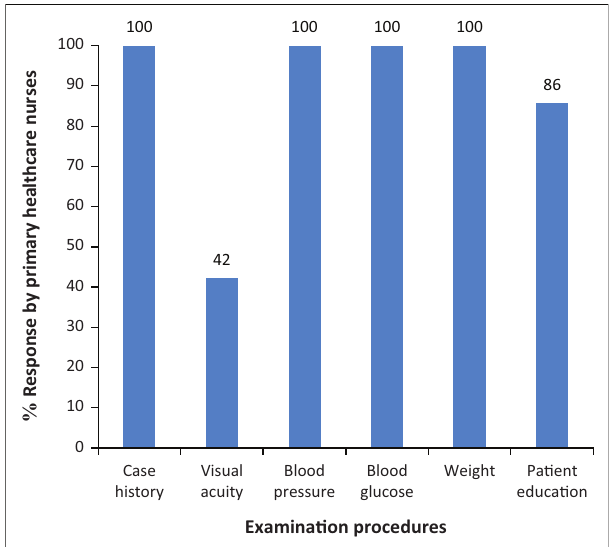
FIG URE 2: Percentage of self-reported competency level of primary healthcare nurses in conducting examination